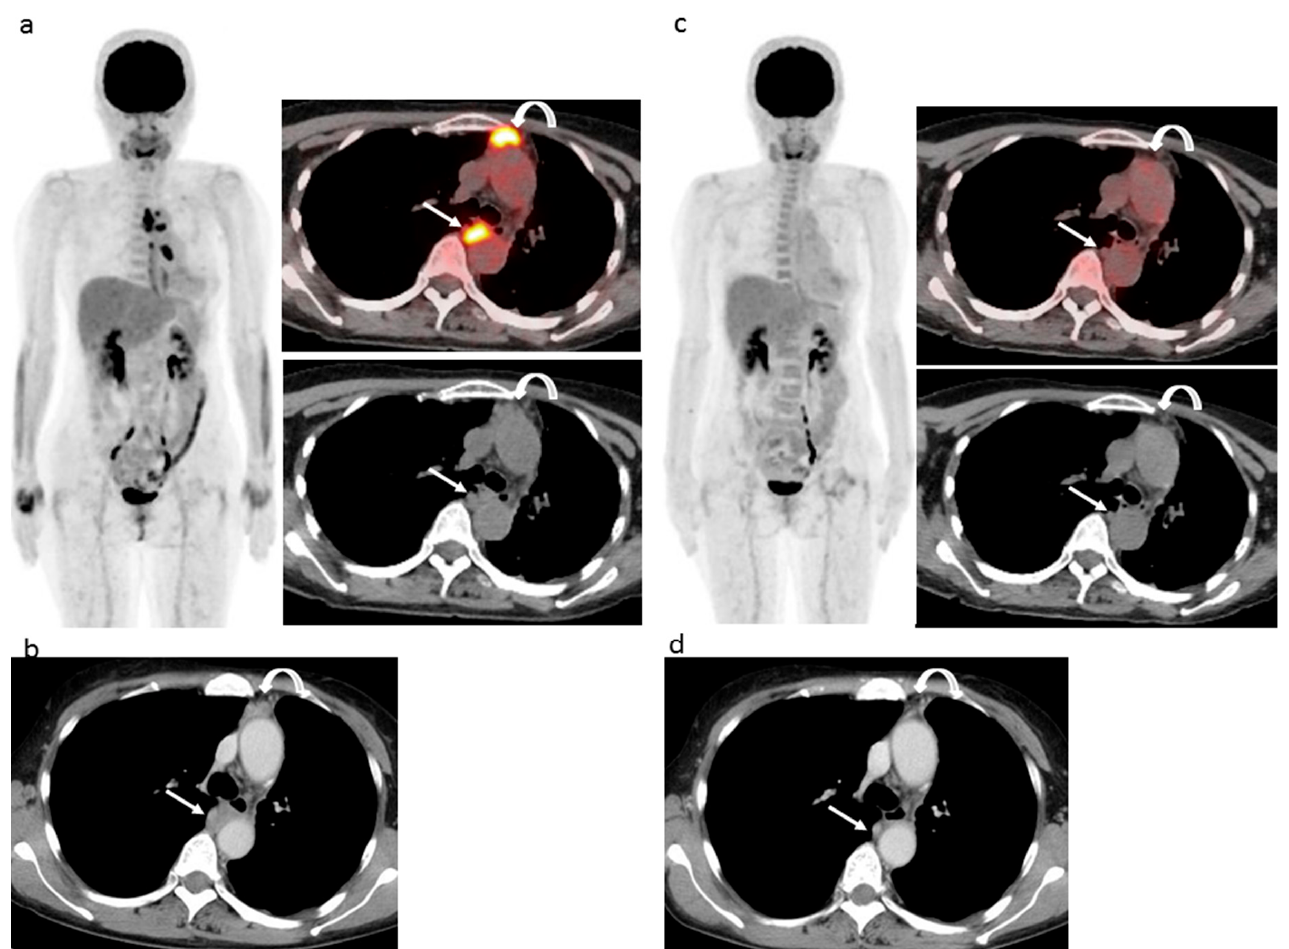
Figure 1. 61 year-old woman with left epithelioid malignant pleural mesothelioma who previously received neoadjuvant chemotherapy (pemetrexed + cisplatin), pleurectomy, and decortication surgery (pT3N1M0), then six cycles of chemotherapy (pemetrexed + cisplatin) after the operation, followed by 10 cycles of second-line therapy (irinotecan + gemcitabine) and then nivolumab as third-line chemotherapy. ( a ) Pre-nivolumab treatment FDG-PET/CT shows several areas of strong FDG uptake related to a pleural lesion (curved arrow) and mediastinal lymph nodal lesion (arrow). ( b ) Pre-nivolumab treatment contrast-enhanced CT shows mass-forming thickness of pleura lesion (curved arrow) and mediastinal lymph nodal lesion (arrow). ( c ) During-treatment FDG-PET/CT after 13 cycles of nivolumab shows FDG uptake disappearance in both pleural (curved arrow) and nodal (arrow) lesions. ( d ) During-treatment contrast-enhanced CT after 13 cycles of nivolumab shows remarkable improvements of both pleural (curved arrow) and nodal (arrow) lesions. EORTC, PERCIST, and imPERCIST indicated CMR. Interpretation of combined modified RECIST and RECIST 1.1 indicated a classification of PR, with the sum pleural lesion size decreasing by 45.5% and the sum mediastinal node size decreasing by 78.3%. The patient continued with 29 more cycles of nivolumab and was alive without progression at 15.1 months after nivolumab initiation.